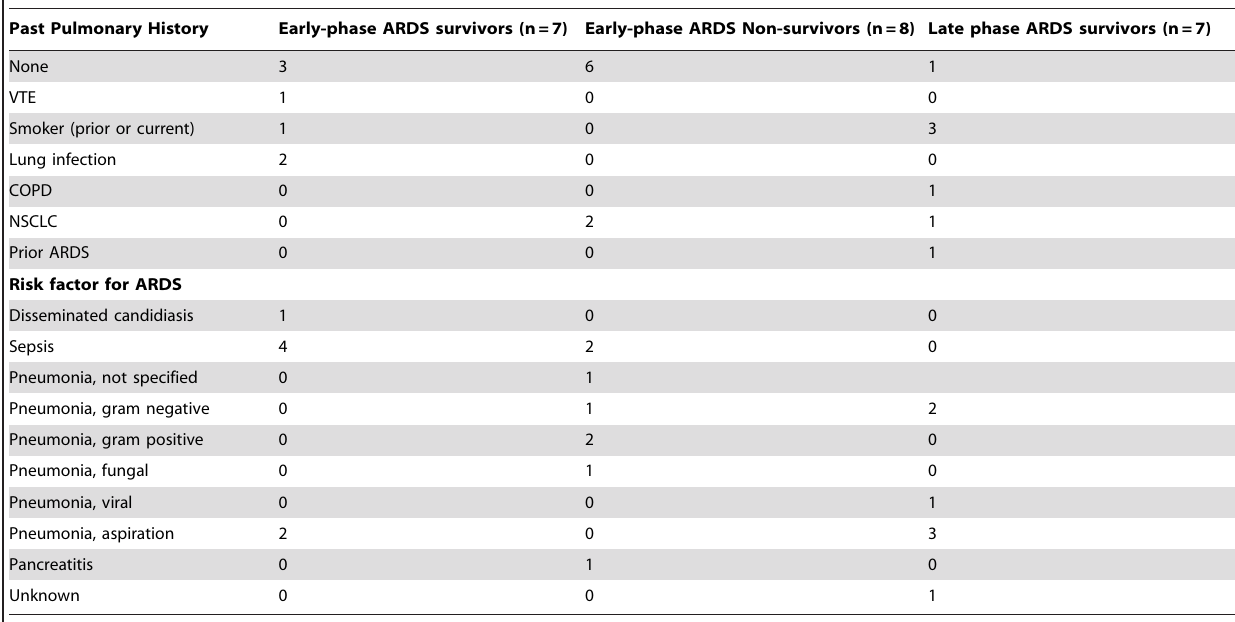
Table 2. Pulmonary history and clinical risk factors for ARDS in the study subjects.